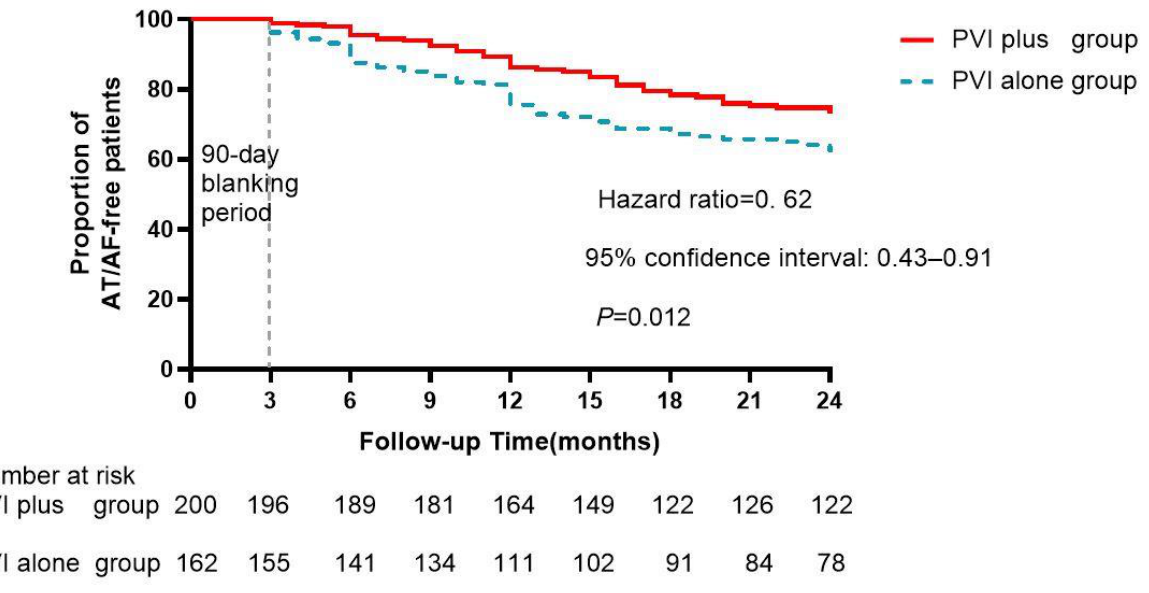
Figure 4. Atrial fibrillation (AF)/atrial tachycardia (AT)-free survival curve after index catheter ablation procedure.